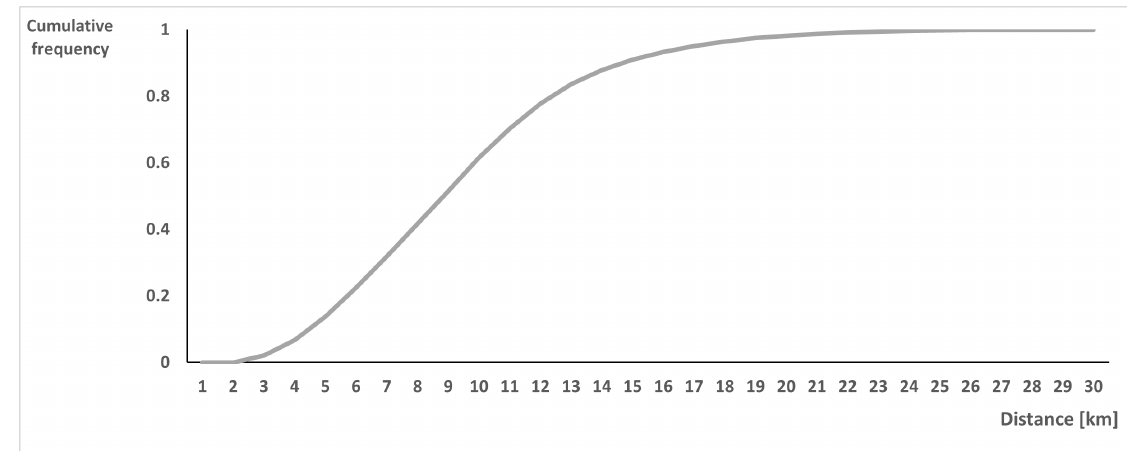
Figure 2. Cumulative distribution function of the distance between pickup points (BRB locations) used for generating random instances for computational experiments. Table 2. Data used to develop cumulative distribution function of the distances between pickup points (BRB locations) used for generating random instances for computational